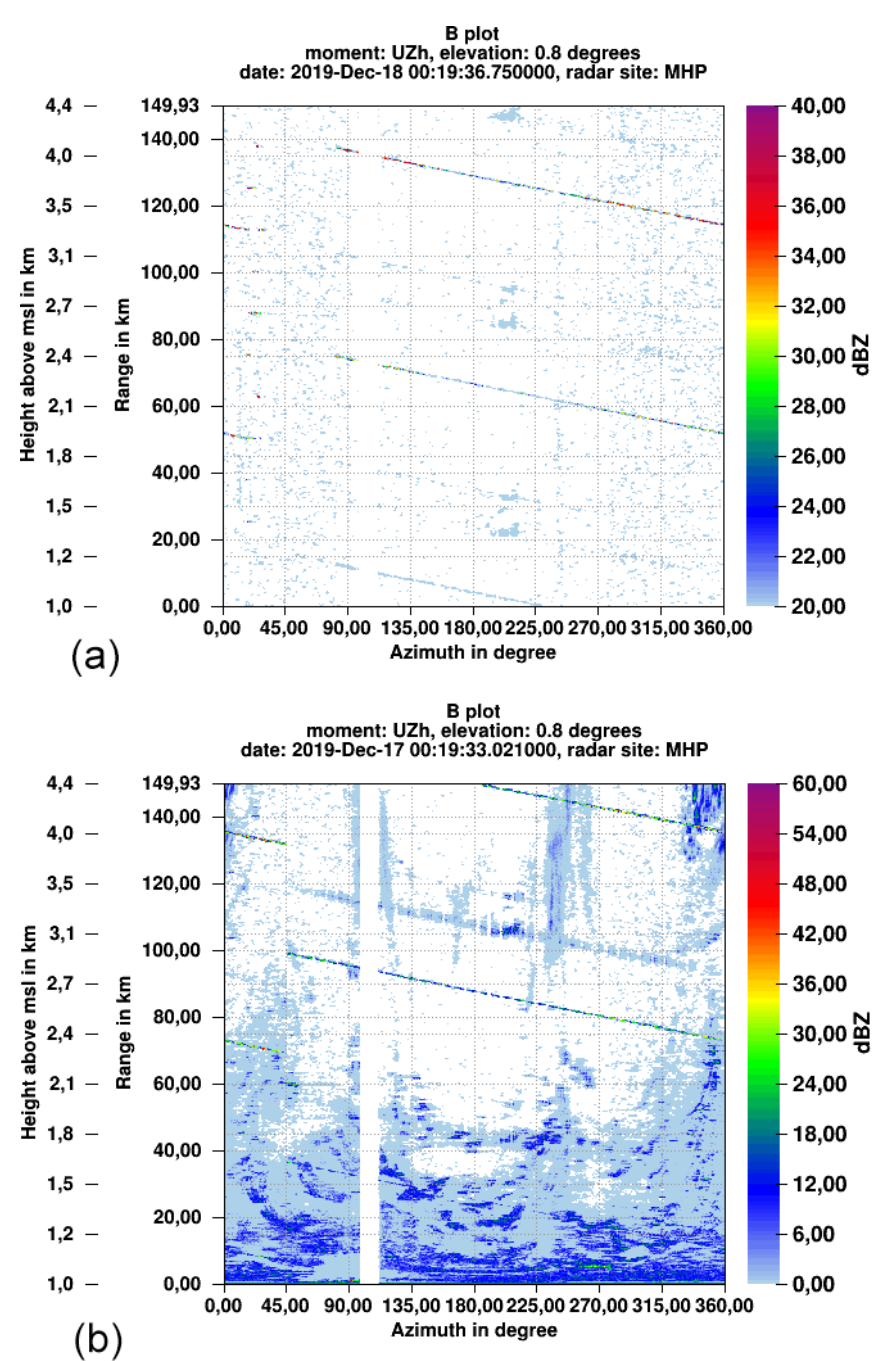
Figure 4. B plots of uncorrected reflectivity (UZh) illustrating the interference from the Eisberg (EIS) radar (line shape structure). (a) Trans- mitter turned off, MHP radar only in receive mode. (b) MHP transmitter operating. Corresponding STD B plots are shown in Fig. 5.